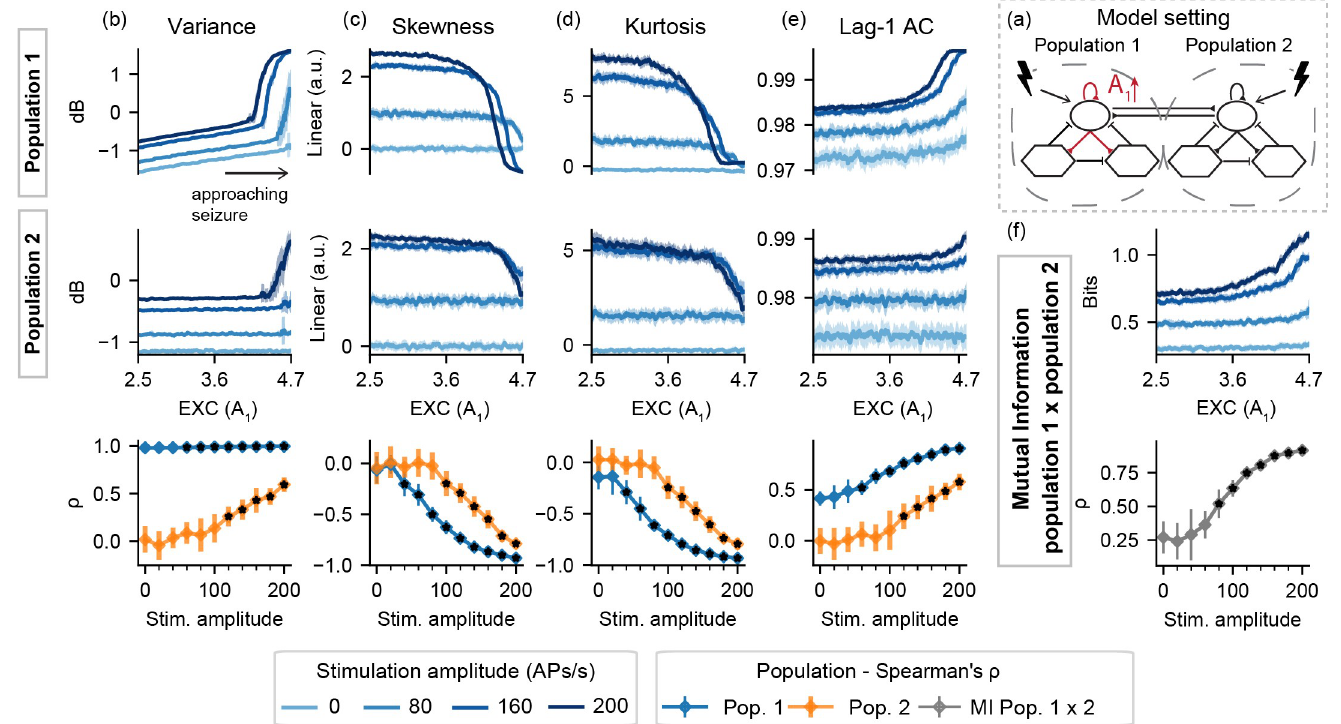
Fig 6. Feature series and probing efficiency for model setting II-A. Active probing effects are visible for population 2, but only for increased stimulation amplitudes. (a) shows a simplified illustration of the model setting. For (b) variance, (c) skewness, (d) kurtosis and (e) lag-1 AC features, top rows show feature values extracted from the output of each population, as the excitability gain parameter (A 1 ) is increased. (f) shows the inter-population synchronization as measured by the mutual information feature. Bottom row shows Spearman’s rank correlation between each feature series and the shifted parameter (A 1 ), as stimulus amplitude is